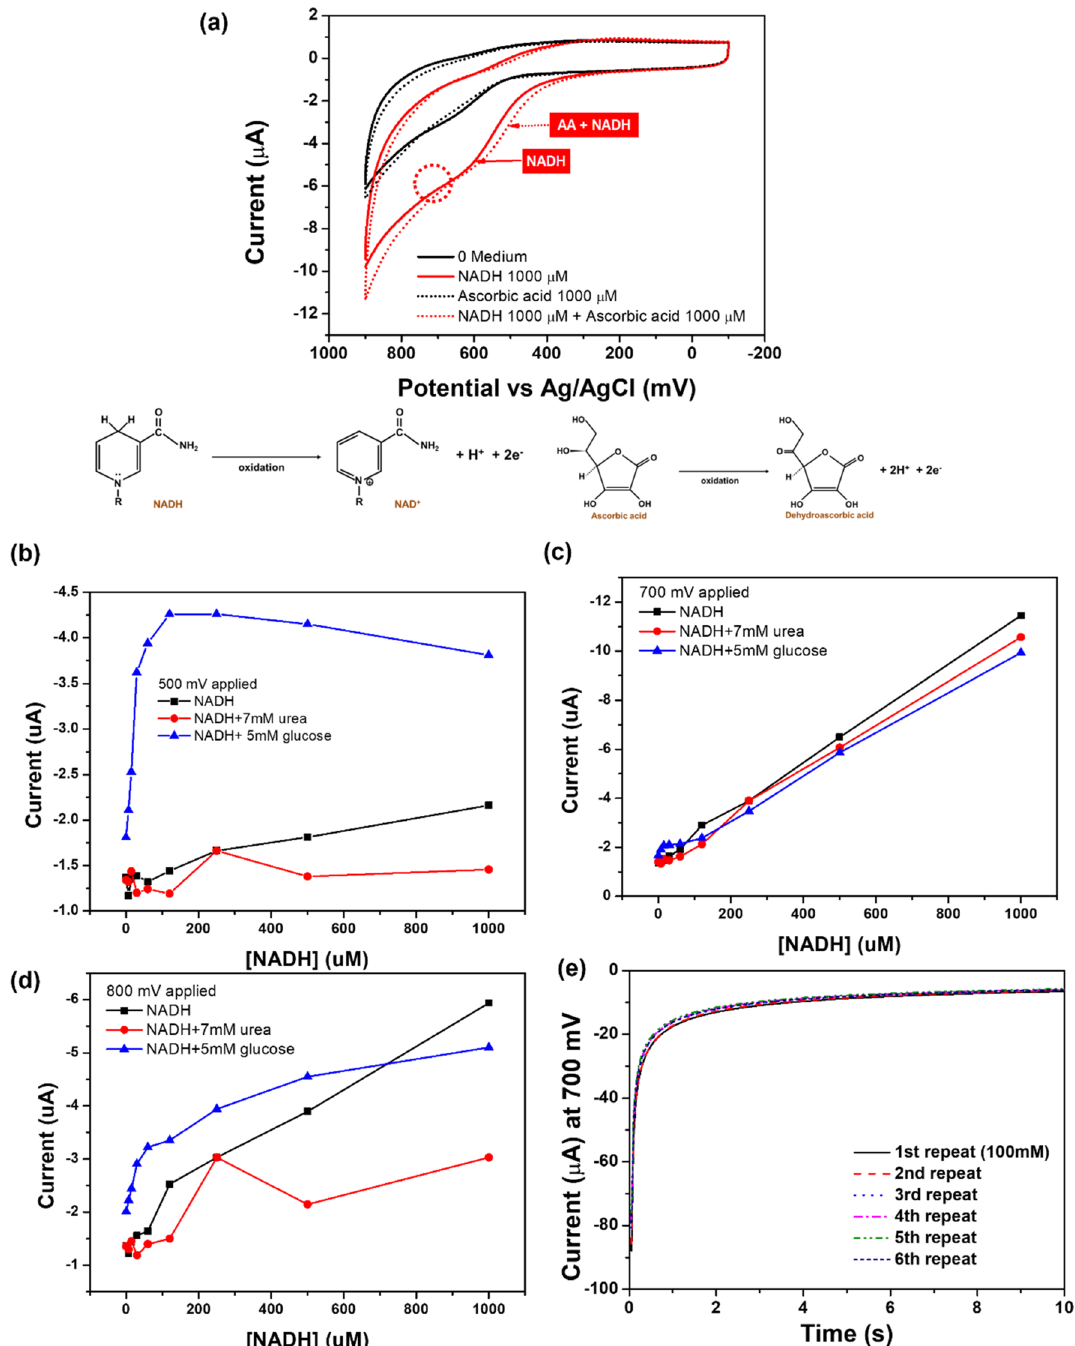
Figure 3. ( a ) Selectivity test with NADH and AA. ( b – d ) Signal difference for NADH with the addition of other impurities at ( b ) 500 mV, ( c ) 700 mV, and ( d ) 800 mV. ( e ) Stability test of NADH with repeated measurement (500 μM NADH solution was used).